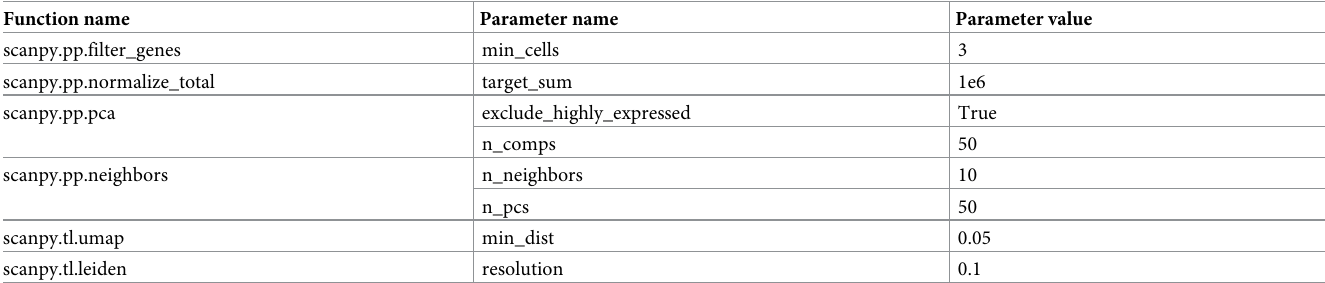
Table 1. SCANPY parameters used for